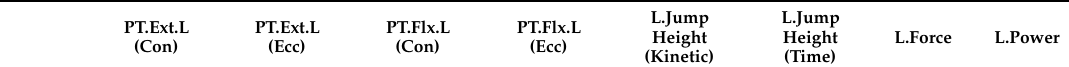
Table 4. Person’s correlation matrix between all isokinetic and force platform variables measured from the countermovement jump of the non-dominant side.